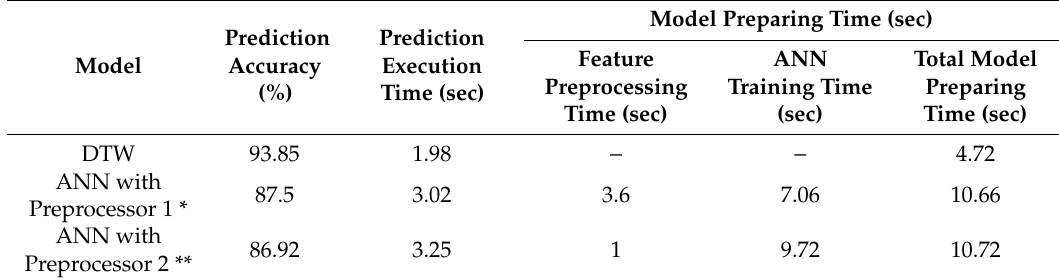
Table 5. Performance conclusion in both accuracy and execution time.